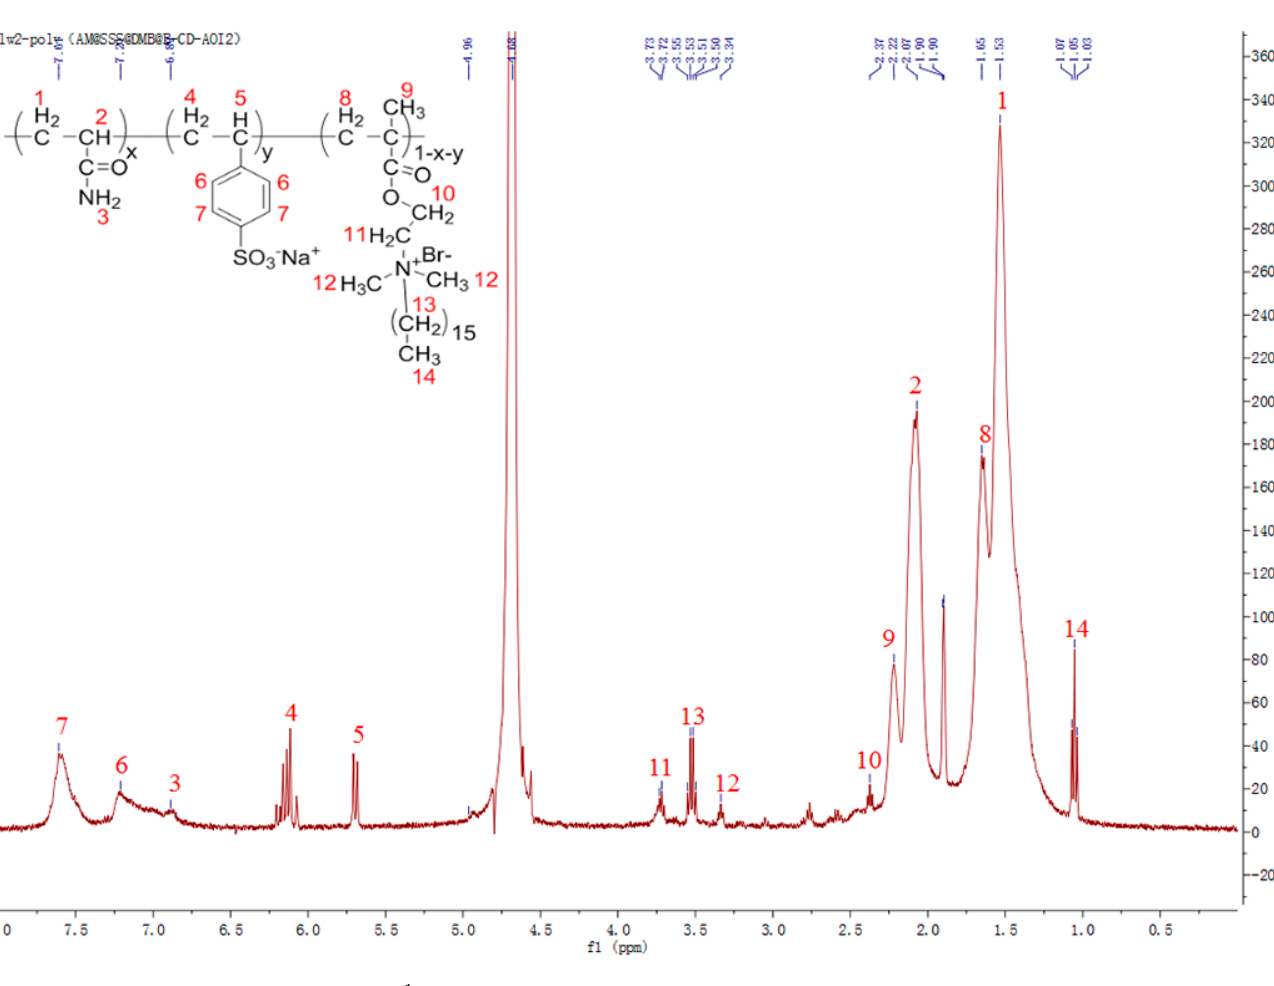
Figure 5. 1 H − NMR spectrum of ASD.